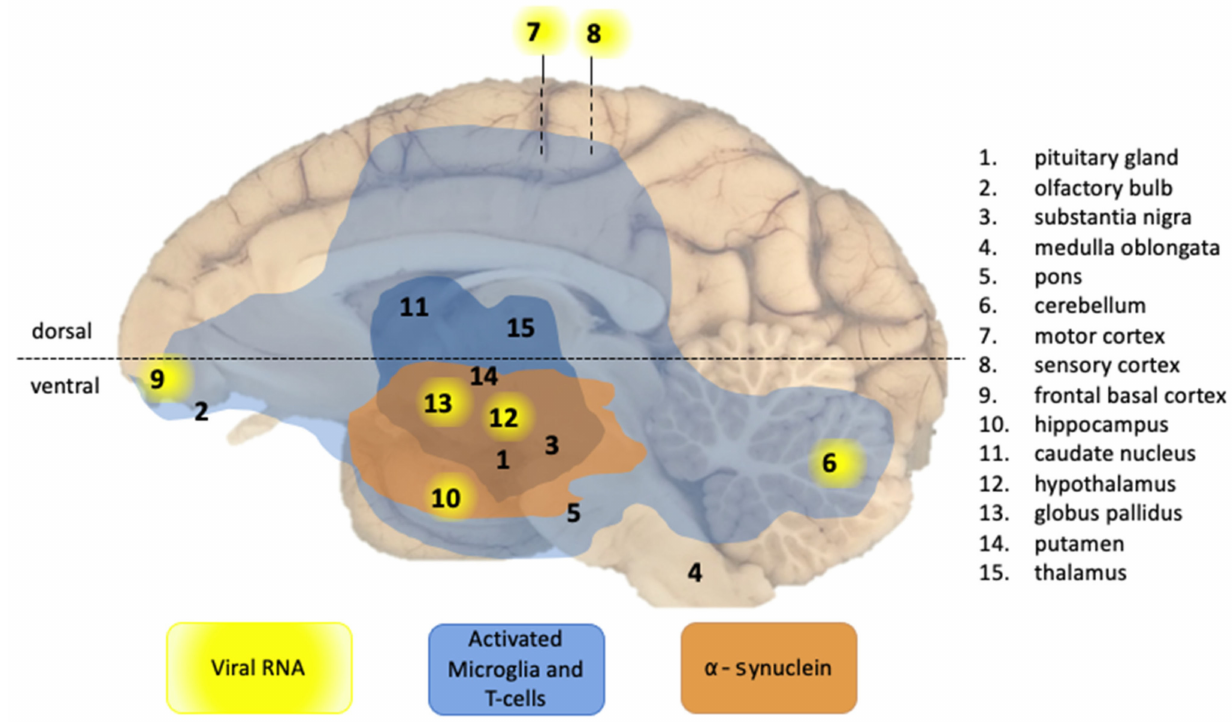
Figure 3. Overview of CNS effects of SARS-CoV-2 infection detected in a macaque brain in this study. The presence of viral RNA was investigated in multiple regions of the brain, as indicated by the numbers. Viral RNA-positive regions in cynomolgus macaque C3 are indicated by a yellow background. Brain areas with infiltrated T-cells (CD3+) and activated microglia (Mamu-DR+) are shown in light blue (low expression) and dark blue (moderate expression). Brain areas with Lewy bodies ( α -synuclein+) are depicted in orange. Blue and orange areas comprise of the combined observations from all animals. The horizontal dotted line indicates the border between the dorsal and ventral parts of the